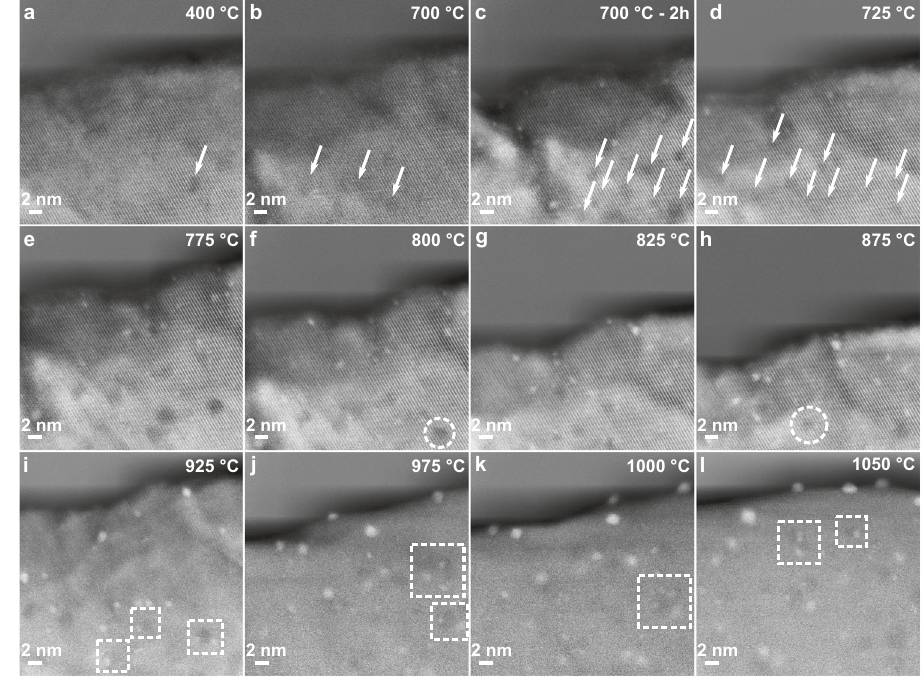
Fig. 5 | Clustering of defects observed during in situ exsolution. a – l STEM images acquired at different temperatures (from 400 to 1050°C) during an in situ heating experiment of a 0.5% Ir-doped STO grain after applying a background subtraction algorithm. The arrows in ( a – d ) highlight the presence and increase in